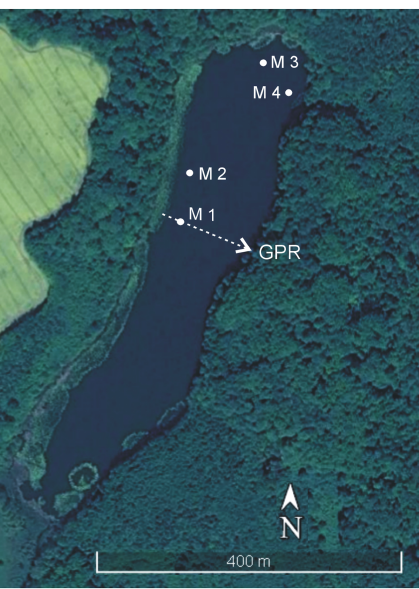
Figure 3. Młynek Lake: location of drillings M1–M4 and transect of GPR sounding (© Google Earth: http://www.google.com/intl/pl/